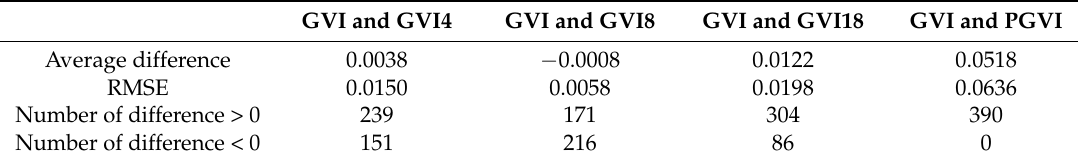
Figure 12. The green view index (GVI) values calculated by different methods. Table 3. The difference values of four green view index (GVI) comparative